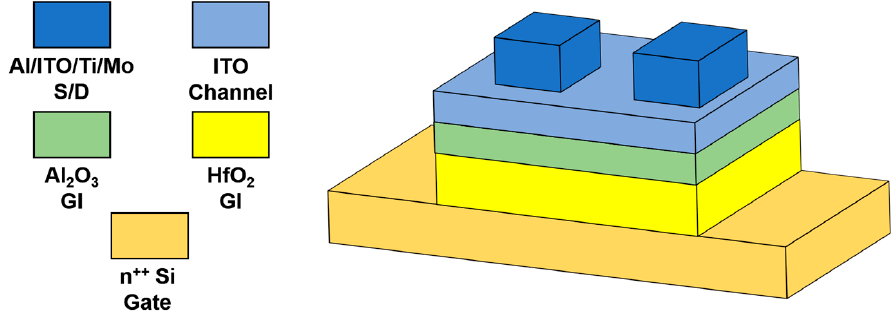
Figure 1. Schematic device structure of ITO TFTs.